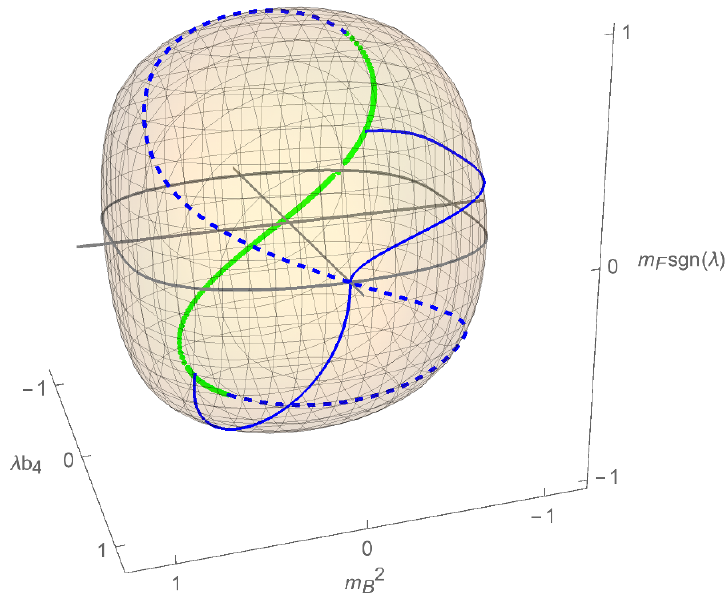
. The (cid:12)rst 4